Question: Give a one-sentence summary of this figure.
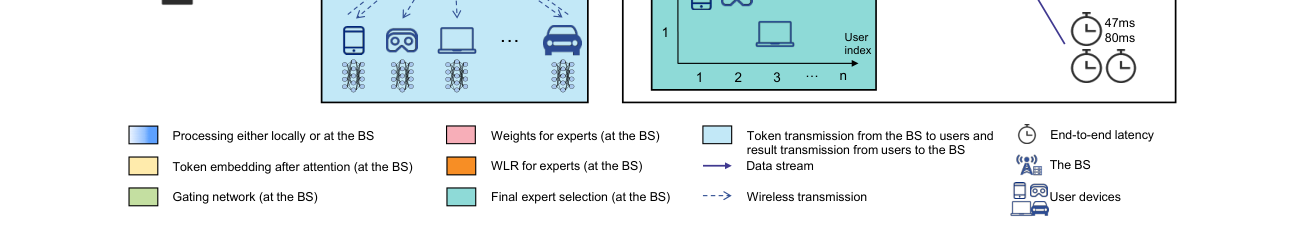
Answer: The data stream and expert selection in WDMoE. When a user sends a prompt to an MoE-based LLM, it is preprocessed, embedded, and subjected to attention operations either locally or at BS, depending on user preference. Each token’s embedding is then analyzed by a gating network to assign weights to each expert. WDMoE dynamically adjusts these weights and the number of experts based on gating network output and user channel conditions at the BS. The token embeddings are sent to the respective user devices for processing by expert networks. Once processed, the results are sent back to the BS, where they are weighted, summed, and then transformed from embeddings into words.